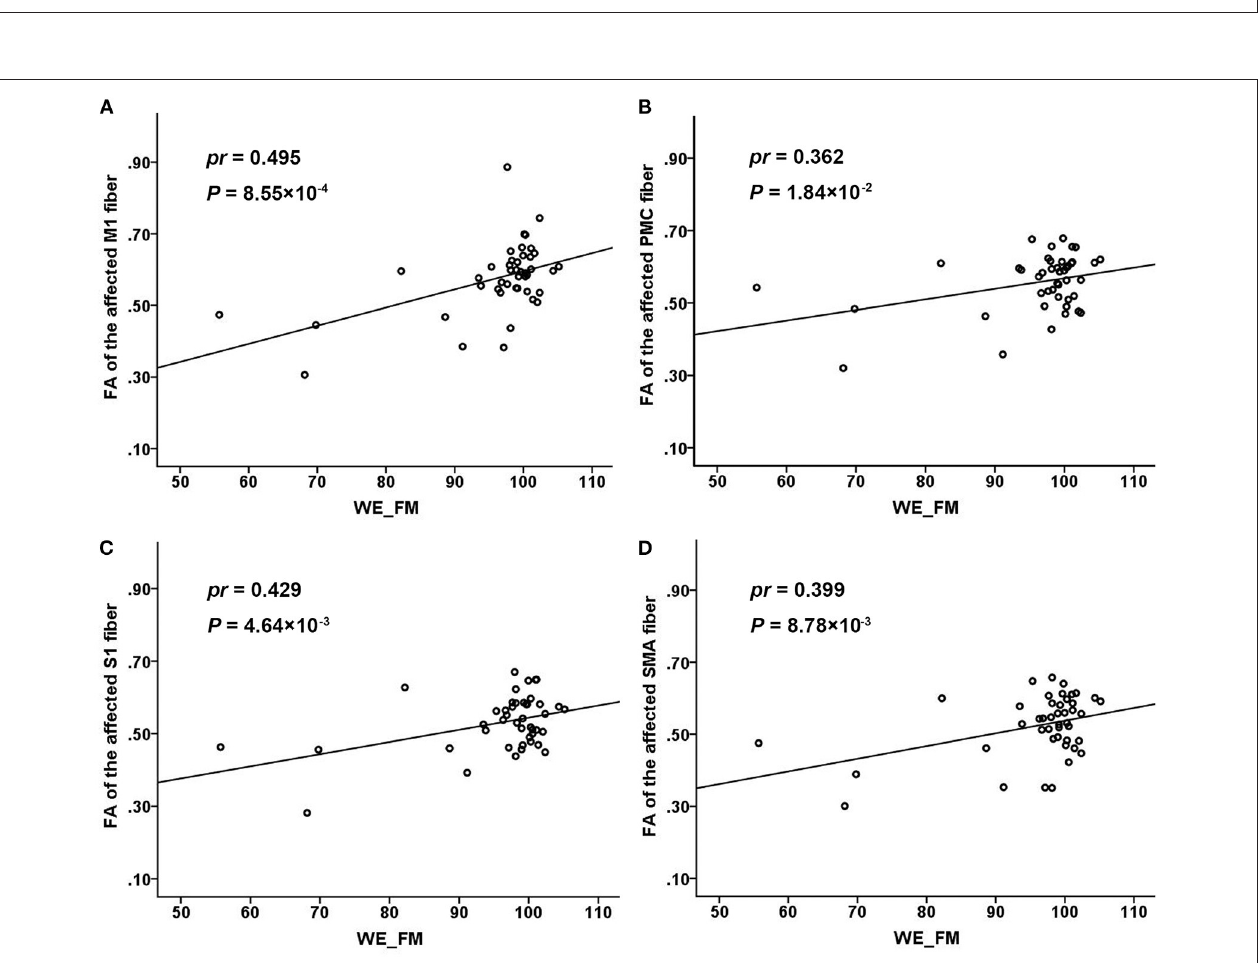
FIGURE 4 | Associations of the FA values of different CST fibers with chronic WE_FM scores in subcortical stroke. The FA values of the affected M1 (A) , PMC (B) , S1 (C) , and SMA (D) fibers in the acute stage were positively correlated with the WE_FM scores in the chronic stage. CST, corticospinal tract; FA, fractional anisotropy; M1, primary motor cortex; PMC, premotor cortex; S1, primary sensory area; SMA, supplementary motor area; WE_FM, Fugl–Meyer Assessment of the whole extremity.